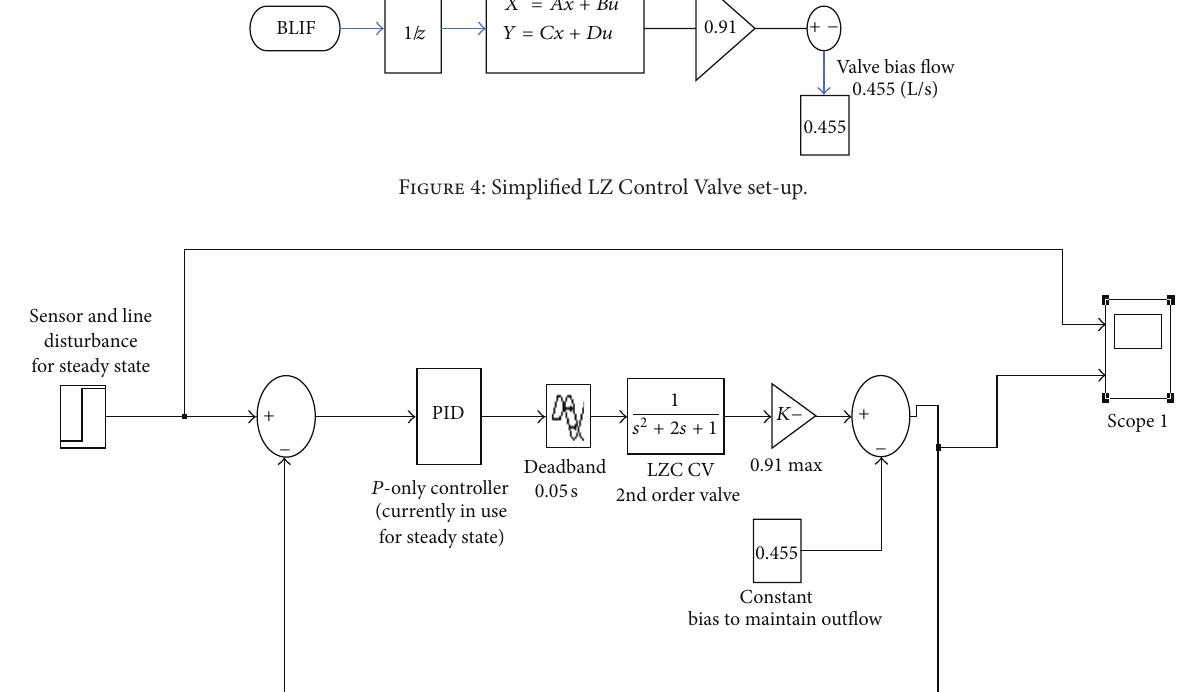
Figure 5: Existing LZ Controller and Valve set-up in